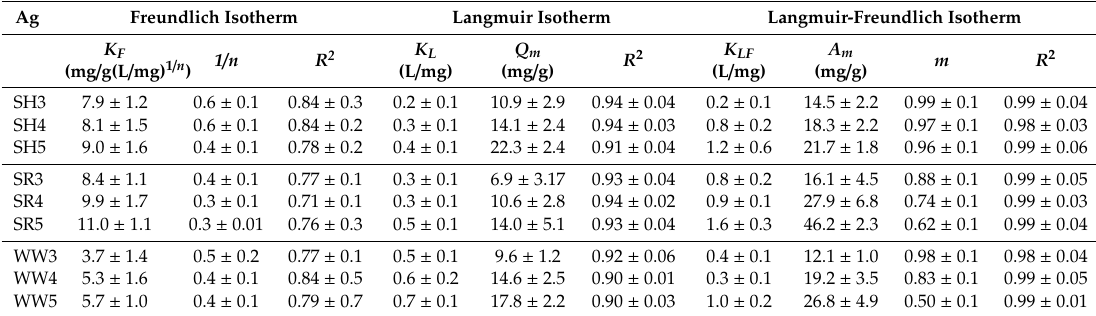
Table 5. Isotherm parameters of the Ag adsorptions on the agricultural biochars with